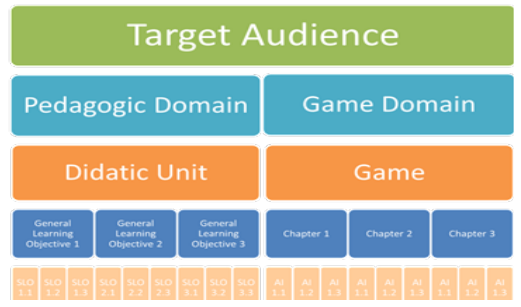
Figure 2. Relationship between pedagogic and game